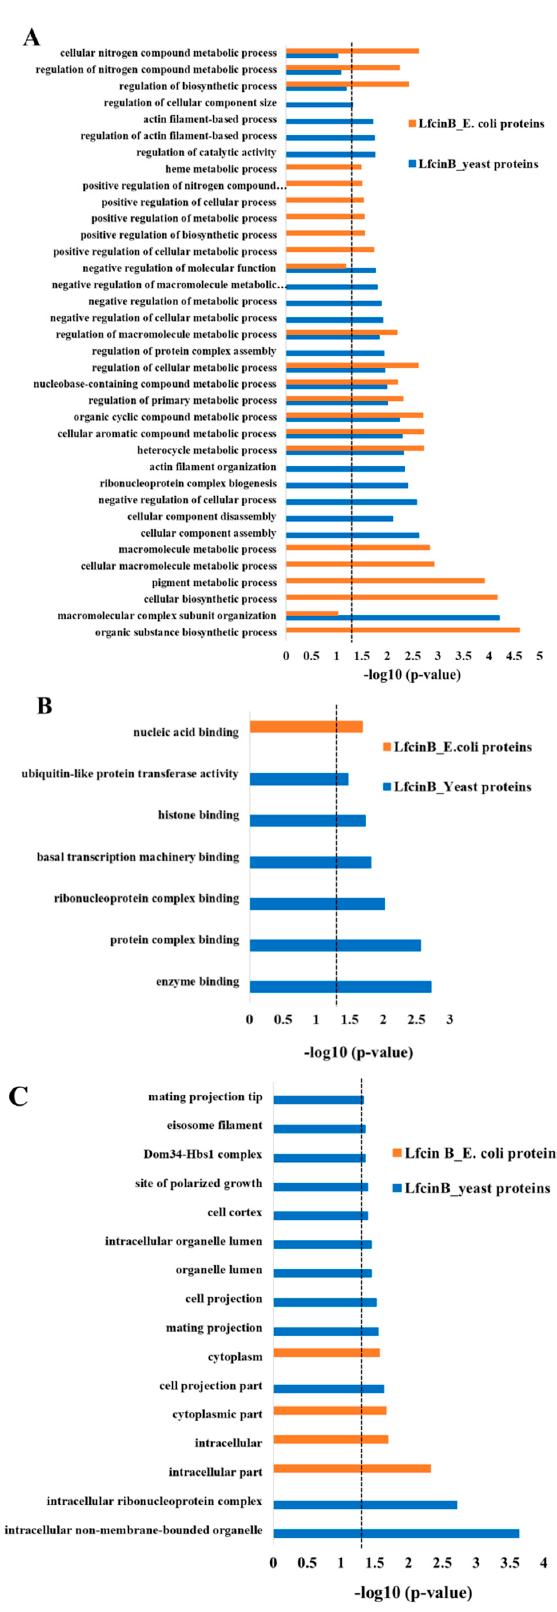
Figure 6. Functional enrichment of Lfcin B hits obtained from E. coli proteome microarray and yeast proteome microarrays. The comparison of enrichment categories of Lfcin B target proteins from yeast and E. coli proteomes. ( A ) Enrichment in biological process ( B ) Enrichment in molecular function and ( C ) Enrichment in cellular component (dotted line indicates the p -value of